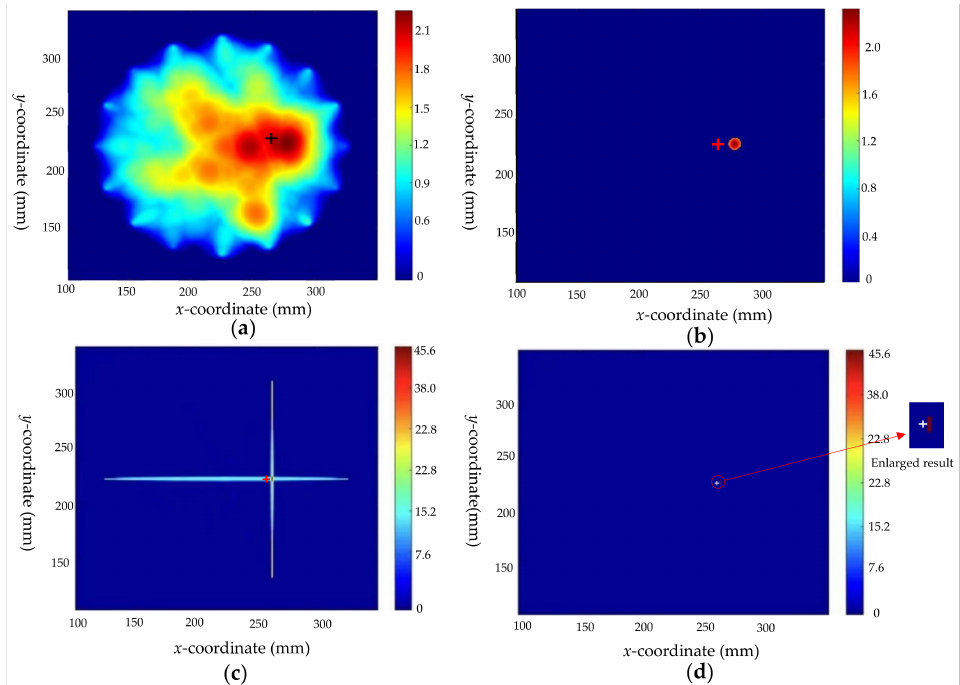
Figure 11. Comparison of imaging results before and after optimization of defect 2: ( a ) imaging results before optimization; ( b ) the threshold processing result before optimization; ( c ) image result after optimization; and ( d ) the threshold processing result after optimization.